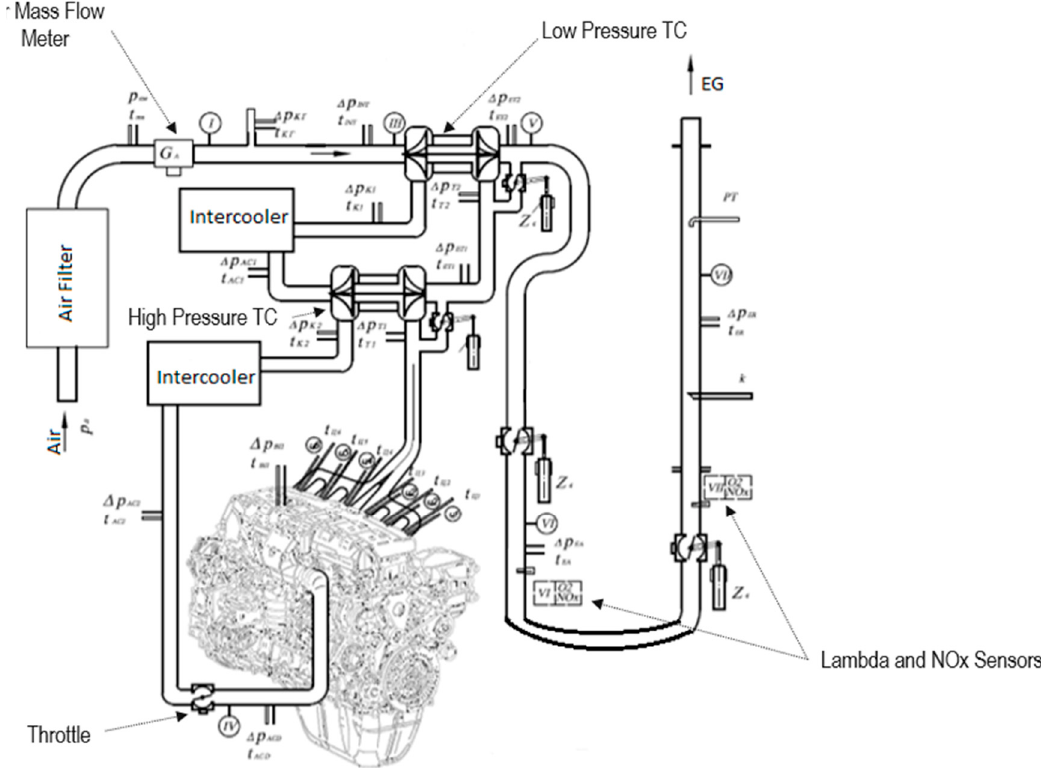
Figure 1. Schematic diagram of experimental equipment.